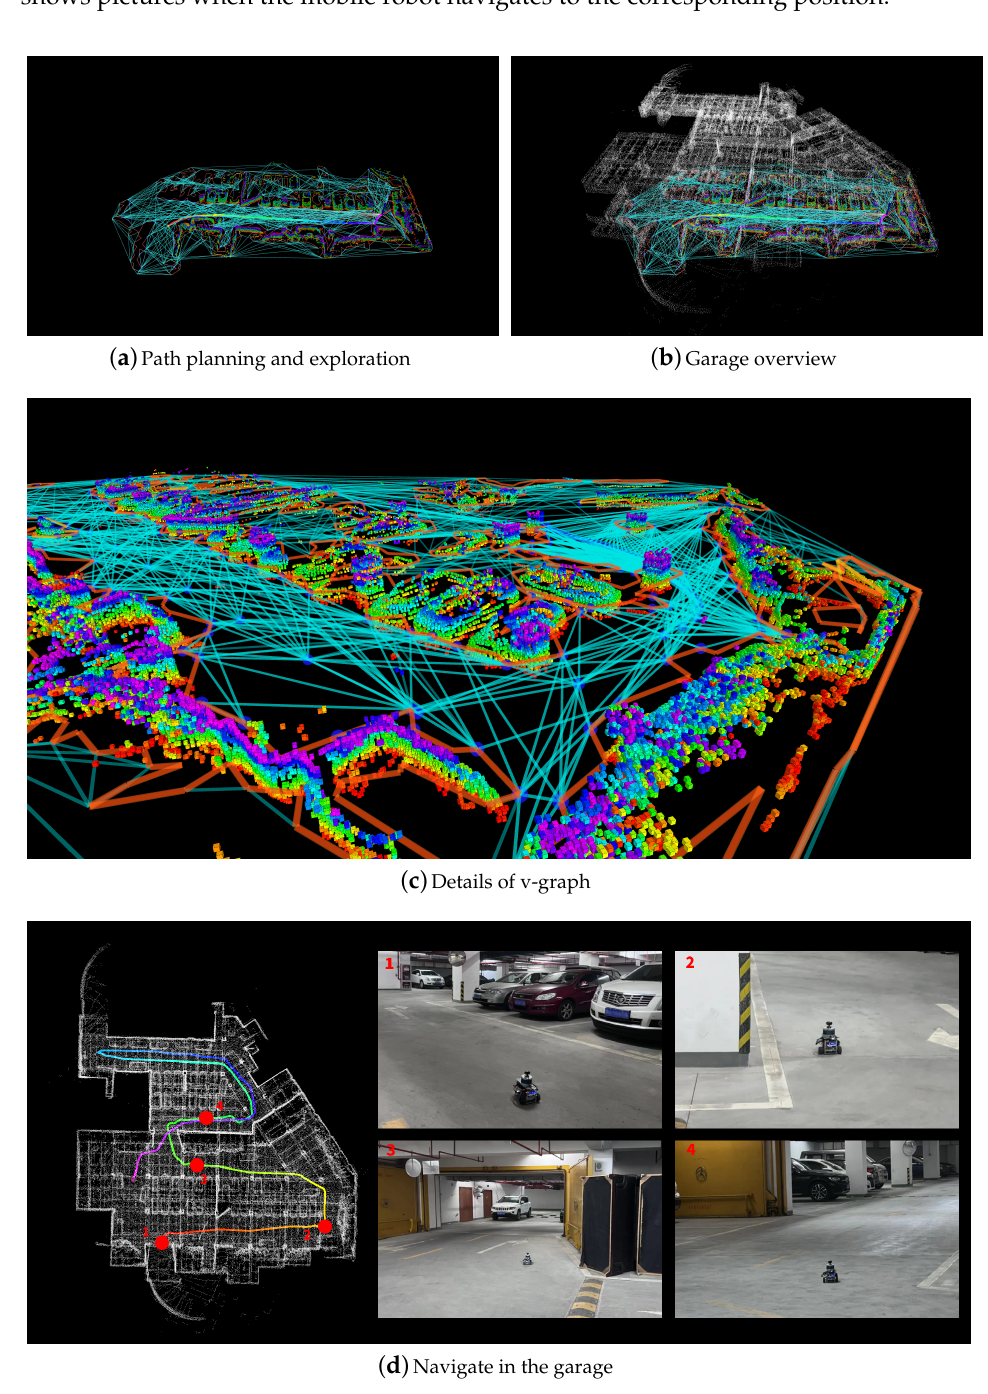
Figure 23. ( a , b ) show the path planning and exploration of the garage. ( c ) shows the details of exploration, and ( d ) shows the entire navigation in the